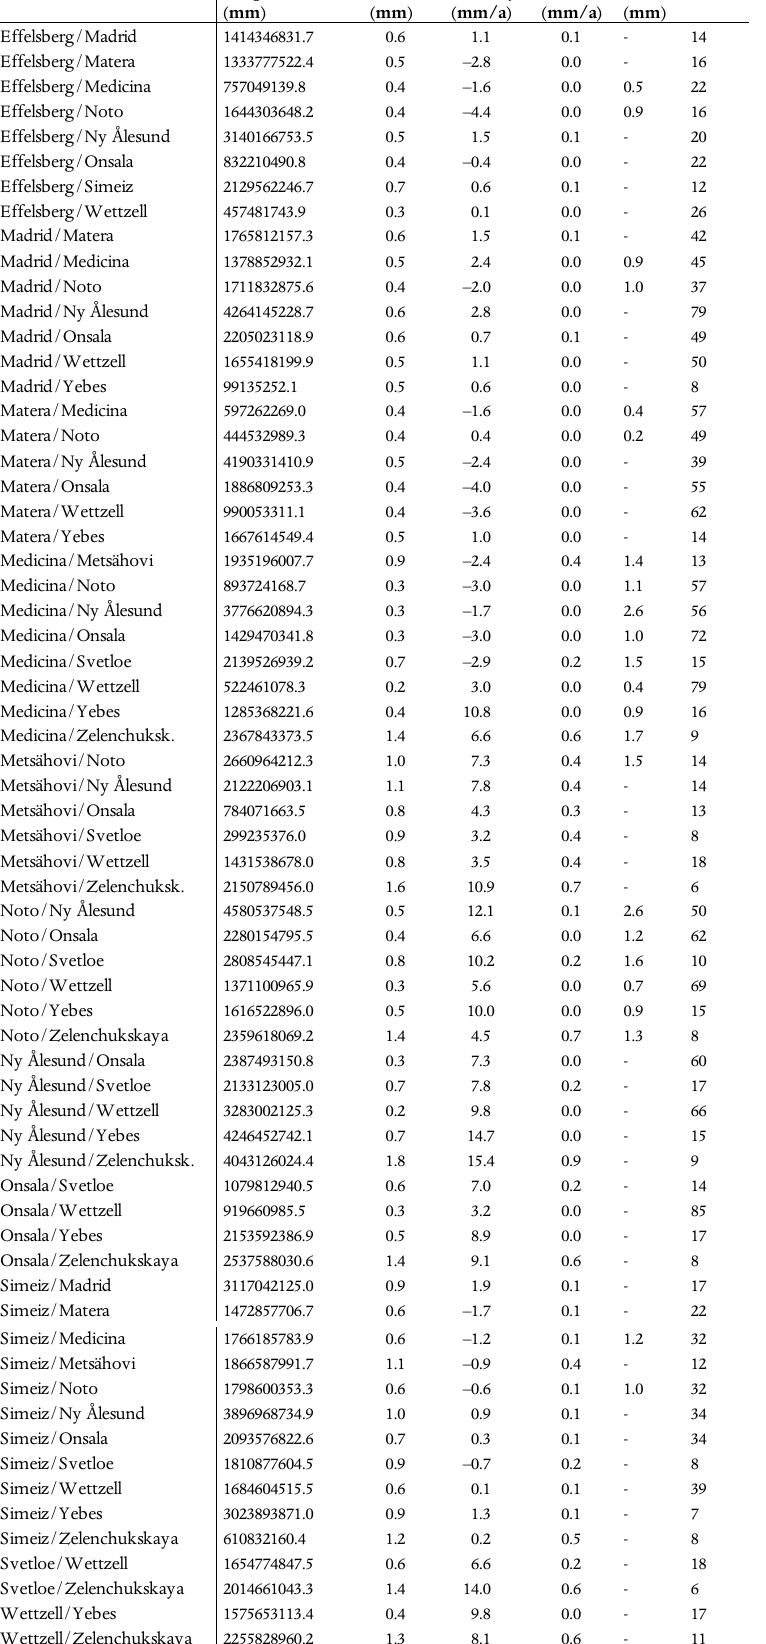
Table 2. Baselines formed by the European IVS stations observed in more than five sessions (column 7). Baseline lengths (at epoch 01.01.2009) and their standard deviations, obtained from solution G , are shown in columns 2 and 3. The rates of change of baselines lengths and their standard deviations are shown in columns 4 and 5. Column 6 contains the differences between the baselines lengths estimated using ( G solution) and not using ( R solution) SPV models. Zero differences are not reported. It is evident that introducing SPV models uniquely affects the baselines formed by stations being corrected for gravitational